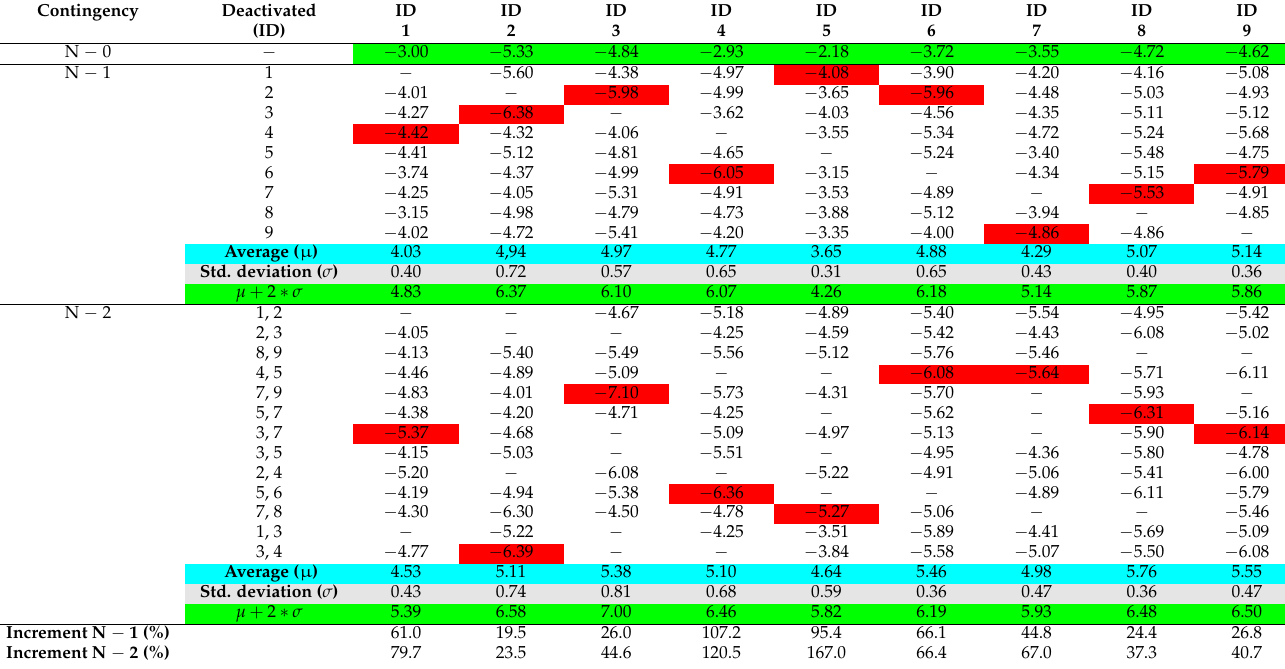
Table 8. Case B: Optimal sizing of charging stations for EVs based on multi-product flow problem. Contingency